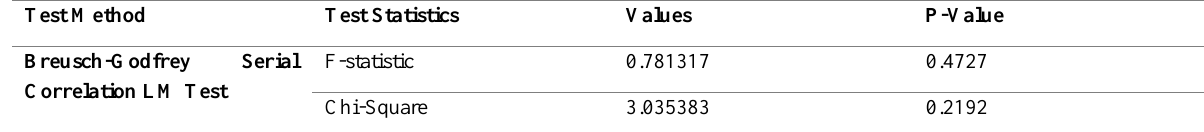
Table 5: Residual Serial Correlation